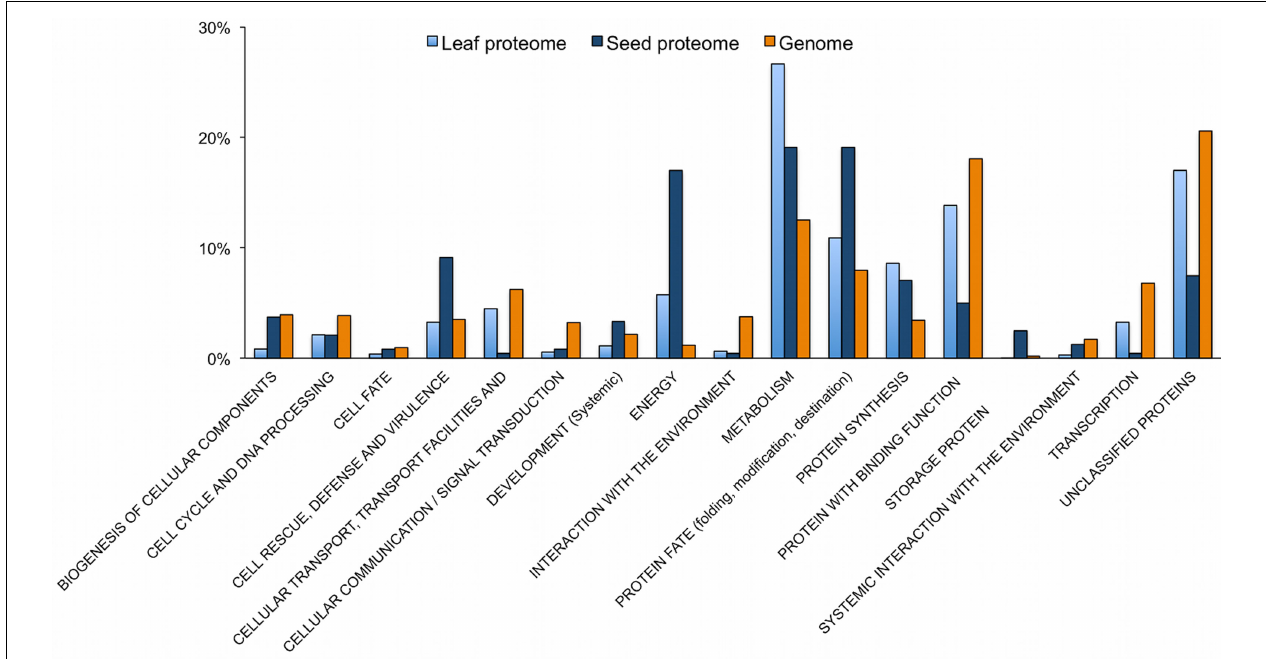
matched to multiple AGI-ID i.e. grouped under an unique AGI.The FunCat catalog was used to annotate the seed proteome, the leaf proteome (from Baerenfaller et al., 2008) and the entire Arabidopsis proteomeTAIR10 Gene Annotation Data; whole genome for